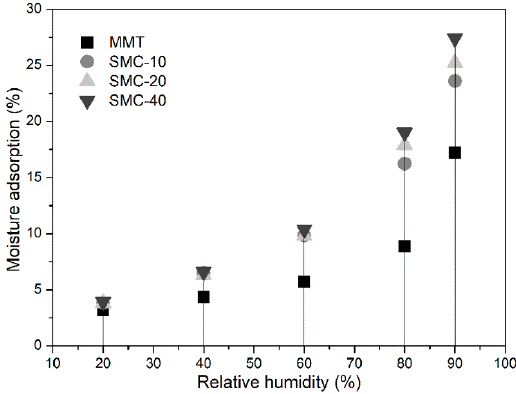
Figure 6. Moisture adsorption of MMT and silica/MMT nanocomposites.